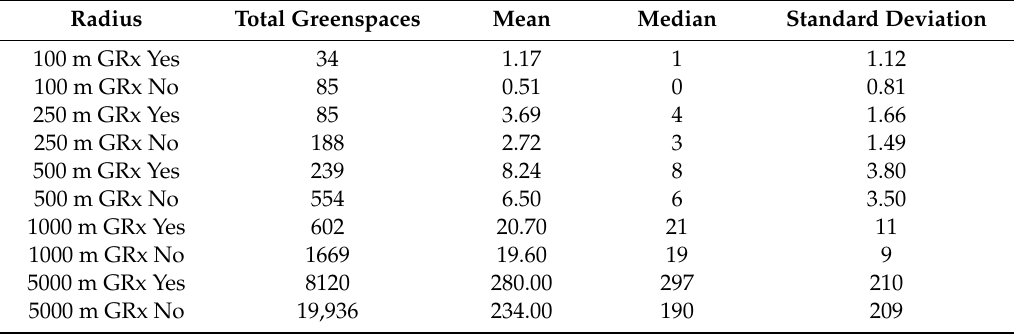
Table 2. Greenspace abundance for all bu ff er radii between 100 m and 5 km (50 m excluded due to data deficiency) around GP surgeries.